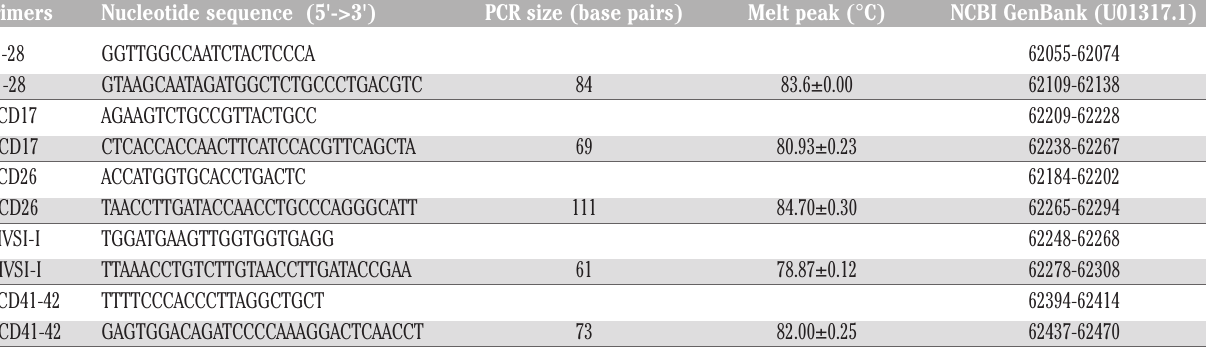
Table 1. The DNA sequence primers, DNA fragment size and melt peak temperature of the modified ARMS RT- PCR using for the detection of the paternally inherited beta thalassemia mutations.